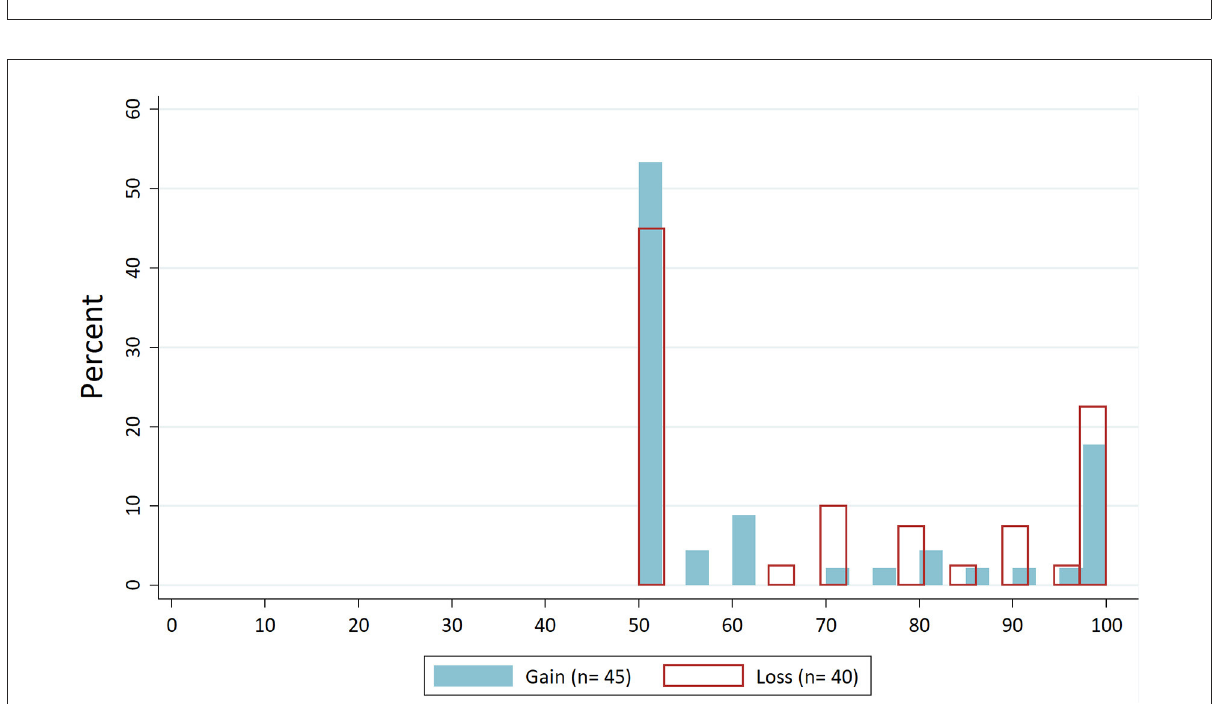
FIGURE6 Distribution dictators’ demands in “Self-interested behaviour”.